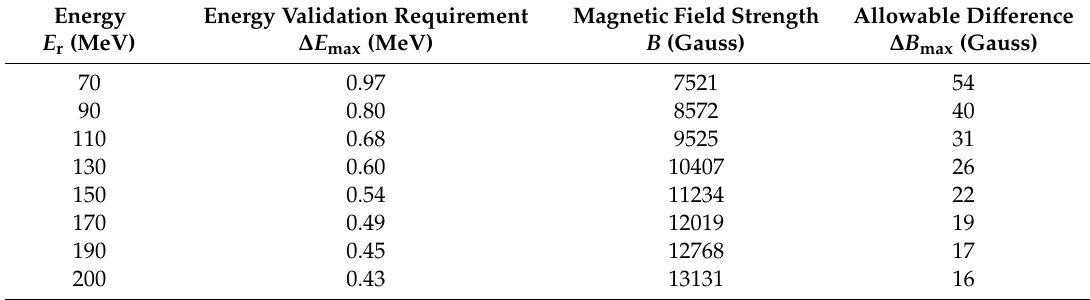
Table 1. Comparison of the magnetic field allowable di ff erence under di ff erent proton